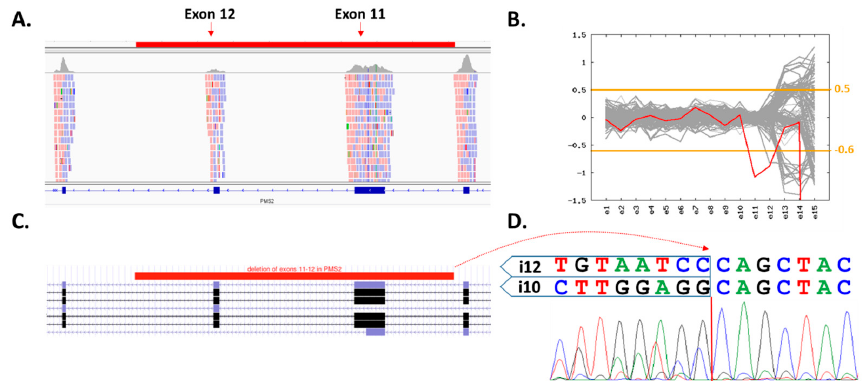
Figure 2. Characterization of exons 11–12 (8,907 bp) PMS2 deletion. ( A ) Integrated Genome Viewer (IGV) visualization of the coverage decrease suggesting a presence of heterozygous two-exon deletion (highlighted region in red). ( B ) Visualization of CNV analyses generated using the CNVkit (patient’s sample in red). The inconsistent region covering exons 12–15 contains numerous PMS2 pseudogenes. ( C ) Schematic region of deletion in UCSC genome browser. ( D ) Characterization of the deletion breakpoint with Sanger sequencing.